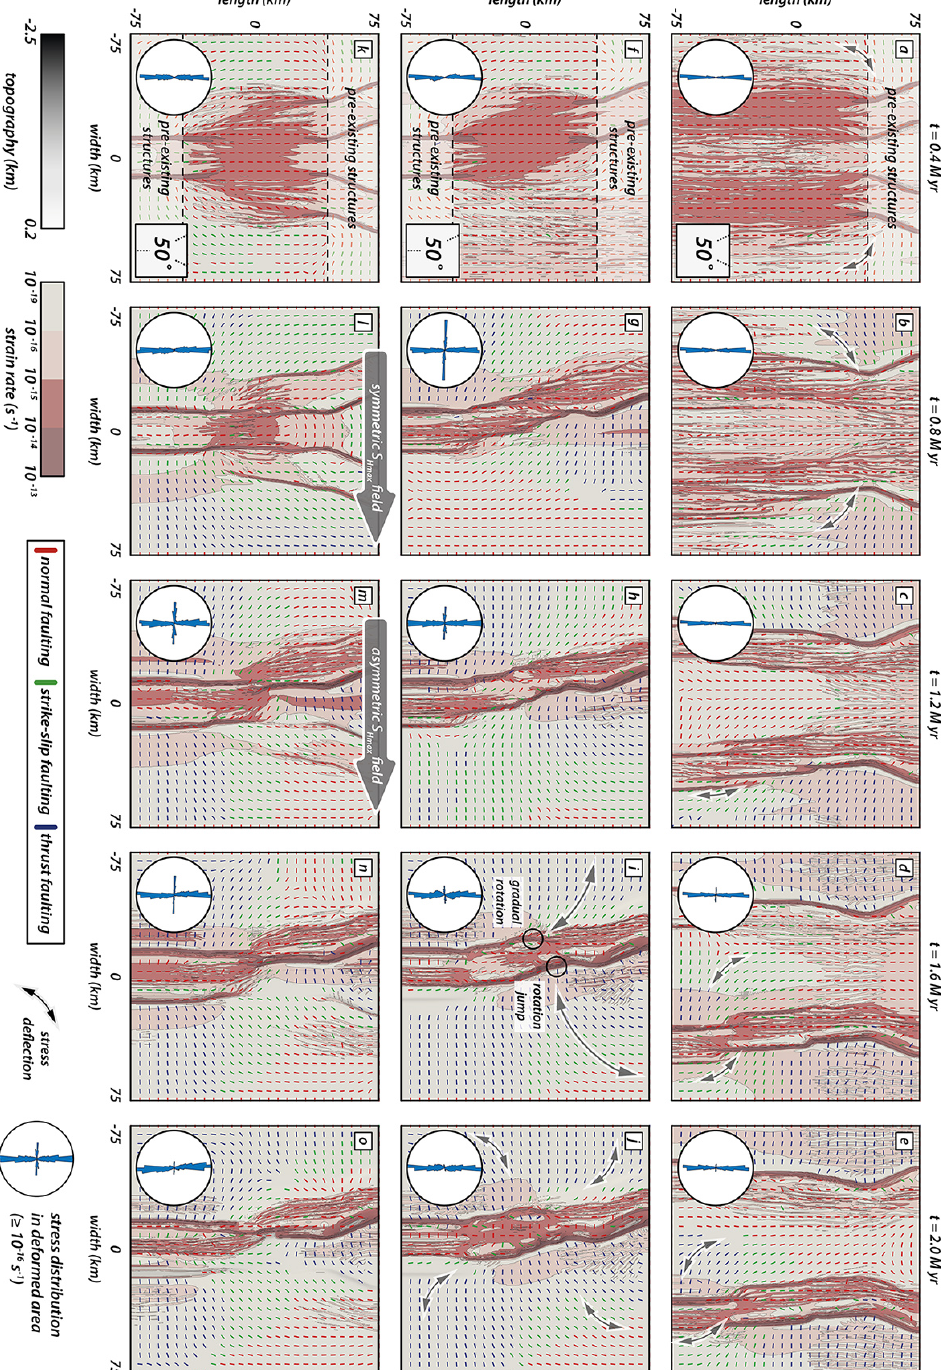
Figure 8. Interplay of rift localization and surface stresses. Top views show the distribution of the maximum horizontal compressive stress component S Hmax (not scaled to the magnitude) in models with an intermediate angle of 50 ◦ at early deformation stages (i.e., until 2 million years). (a–e) The v -seed configuration. (f–j) The i -seed configuration. (k–o) The y -seed configuration. Black refers to topographic elevation and red marks zones wherein strain rates exceed a threshold of 10 − 16 s − 1 . Color coding for the stress regime marks normal, strike-slip, and thrust faulting in red, green, and blue, respectively, using the common color scheme of the World Stress Map (Heidbach et al., 2018). Black arrows highlight stress deflection of S Hmax . Rose diagrams show the distribution of S Hmax orientation in zones wherein active faulting occurs (i.e., strain rate ≥ 10 − 16 s − 1 ). Large grey arrows for the y -seed configuration mark the change from a symmetric to an asymmetric S Hmax